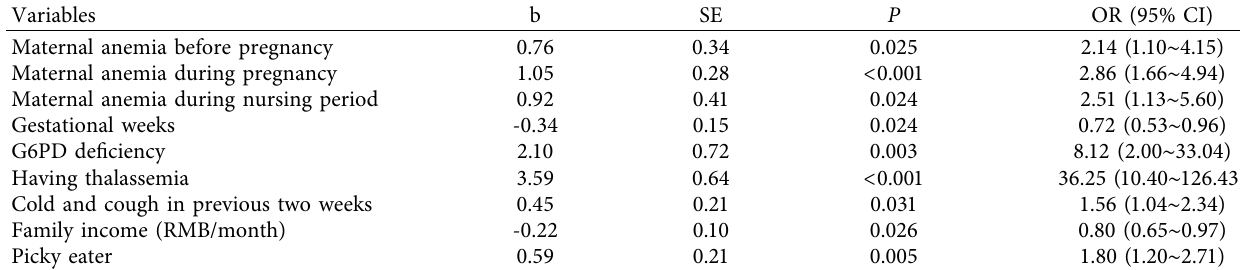
Table 3: Multivariable analysis of determinants of anemia in